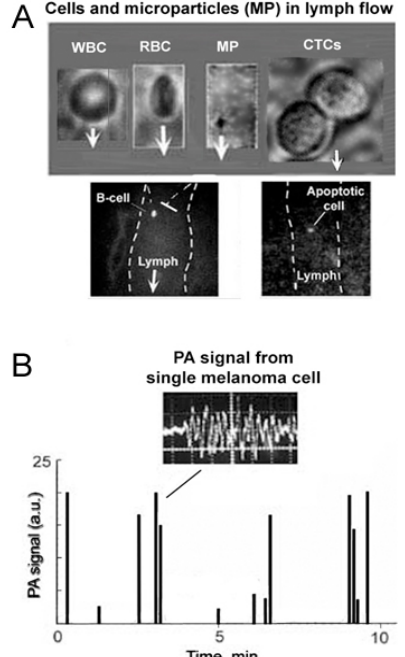
Figure 21. In vivo lymph flow cytometry. ( A ) In vivo FC image with transmission and fluorescence techniques for identification of a WBC, an RBC, a microparticle (MP; likely chylomicron), CTCs, B lymphocytes, and apoptotic WBCs in lymph flow (magnification, 40×; image rate, 500–2,500 fps). ( B ) Application of label-free PAFC for detection of melanoma CTCs in an ear lymphatic in a preclinical animal model of metastatic melanoma (ear tumor in nude mice; week 2 after inoculation); insert: non-compressed time-resolved PA